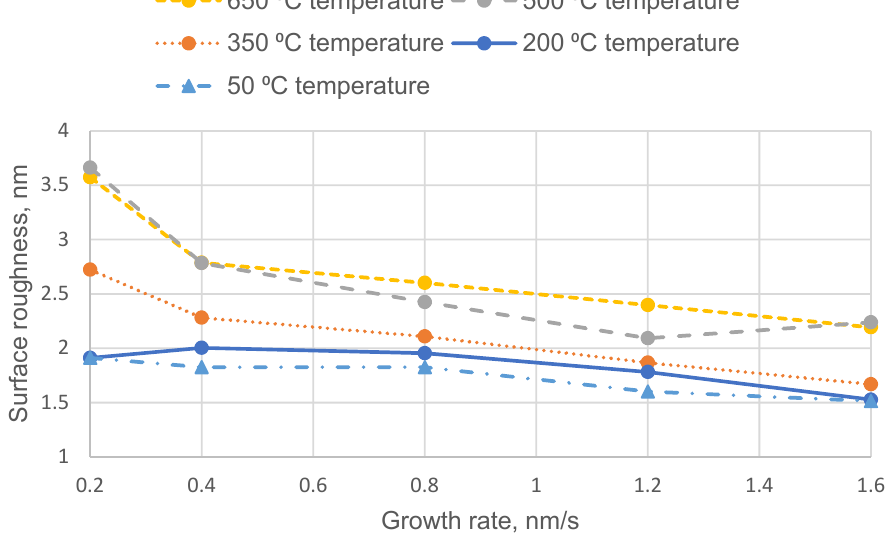
Figure 11. Plots of surface roughness versus growth rate obtained by using different substrate tem- peratures.